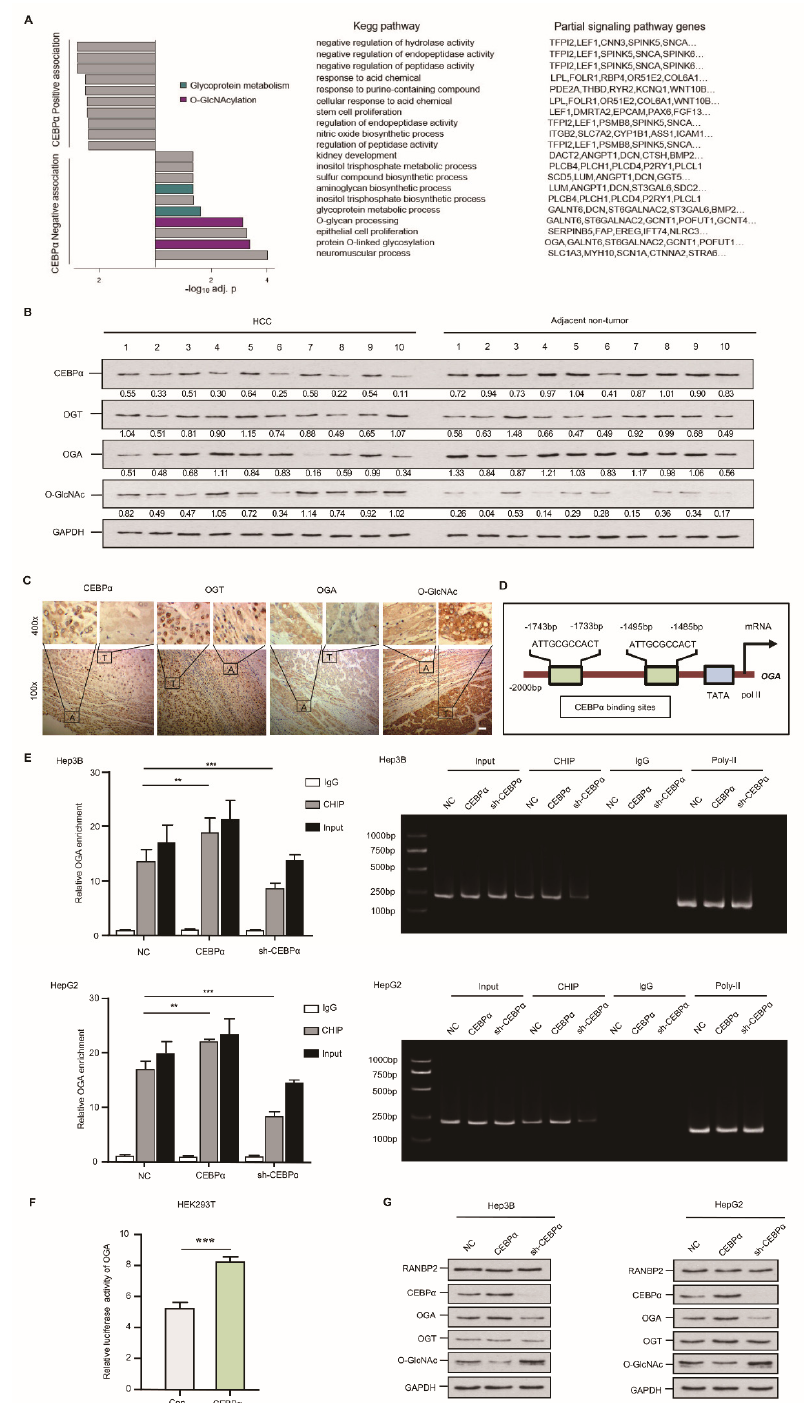
Figure 4. Downregulation of CEBP α is essential for OGA inactivation and hyper- O -GlcNAcylation in HCC. ( A ) CEBP α was negatively associated with response to O -GlcNAcylation and relevant